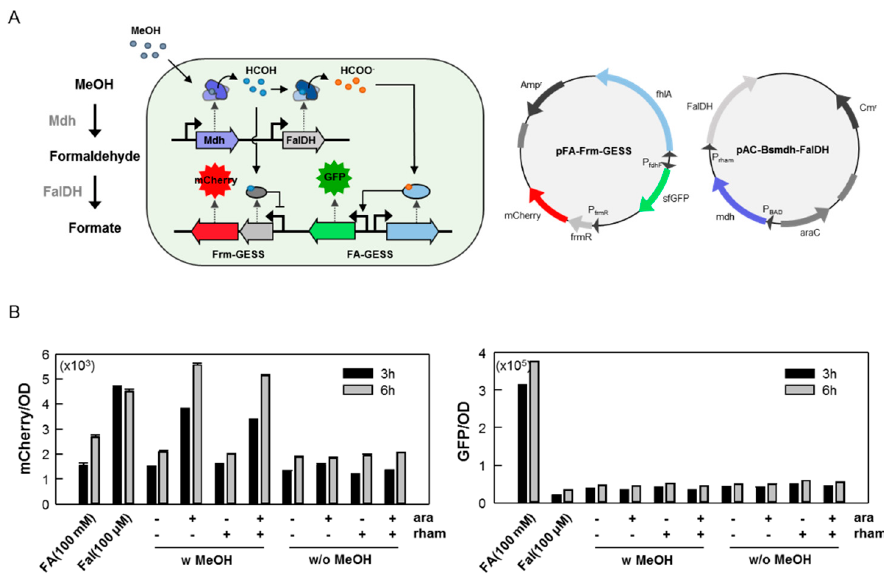
Figure 6. Application of the C1 biosensors to study the enzyme cascade in recombinant cells. ( A ). Schematic view of the operation of the combined C1 biosensor according to the respective enzymatic activity, and the structure of the recombinant vectors used in this study. For recombinant vectors, each sensor modules simply combined by Gibson-cloning method, and the expression of Mdh and FalDH was under controlled by PBAD and Prham promoter, respectively. ( B ). Each biosensor modules was well functioned, independently, when combined each other. The mCherry or sfGFP fluorescence signals was only obtained when the respective substrates were added. Formaldehyde produced by Mdh was detected by Frm-GESS sensor (mCherry signal, left graph), but the formate produced by FalDH was not detected by FA-GESS sensor (sfGFP signal, right graph). All the experiments began with induction (0.2% arabinose, 0.1 mM rhamnose) to express the enzymes during 1 h, followed by the addition of methanol (200 mM). Fluorescence signals were obtained after 3 or 6 h.